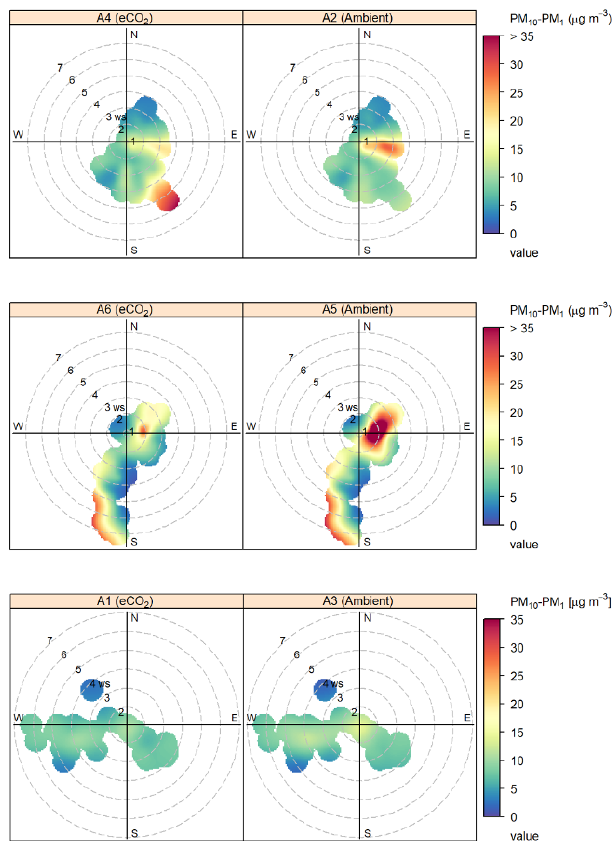
Figure 4. Polar bivariate plots from openair displaying bioaerosol concentrations (PM 10 –PM 1 ), wind speed, and wind di- rection across the autumn 2018 experimental duration at the BIFoR FACE site (Carslaw and Ropkins, 2012). Each row of plots shows the data collected in each of the pairs of arrays (one e CO 2 , one ambient) in which the pair of OPCs were located. Dates of OPC installation in each array pair are detailed in Table 1. Bioaerosols were measured using OPCs at 2m height, and wind data were taken from anemometers at 25m height. Colour gradients display the con- centrations of bioaerosols detected, with low concentrations shown in blue–green colours, mid concentrations in yellow, and high con- centrations in orange–red.